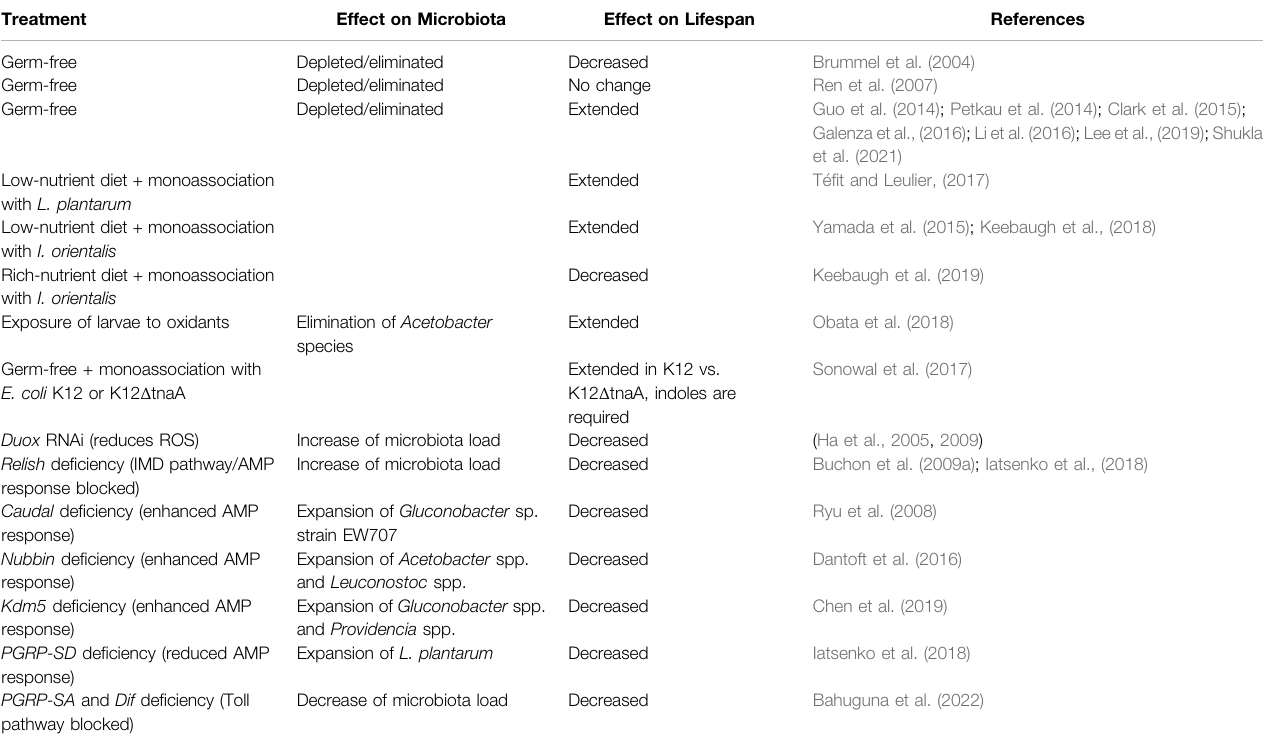
TABLE 1 | Effect of microbiota on Drosophila